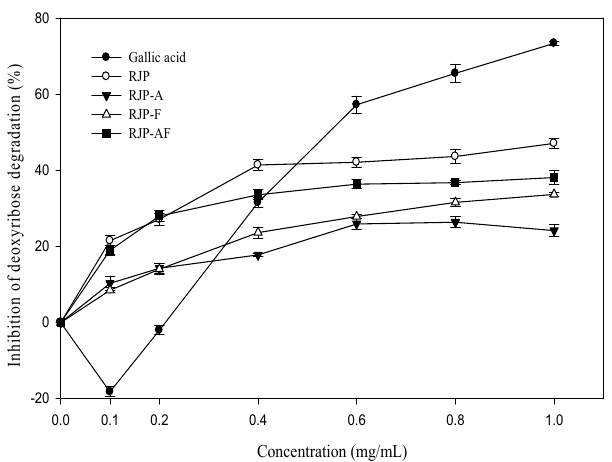
Figure 2. Effect of RJP and RJP hydrolysate on the Fe 2+ -EDTA/H 2 O 2 /ascorbic acid (Asc)-induced oxidative damage of deoxyribose. RJP: Royal jelly protein, RJP-A: Royal jelly protein hydrolyzed by alcalase, RJP-F: Royal jelly protein hydrolyzed by flavourzyme, RJP-AF: Royal jelly protein hydrolyzed by alcalase followed by flavourzyme.